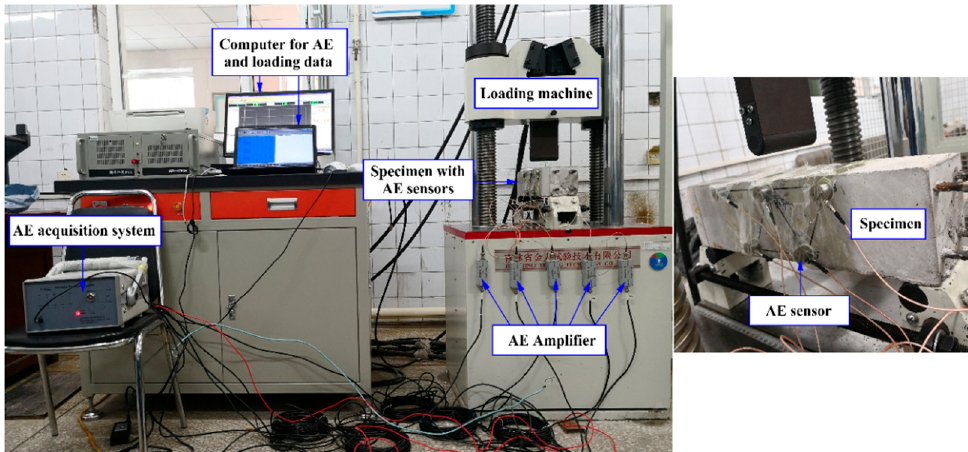
Figure 6. Experimental setups for the bending test and AE test.